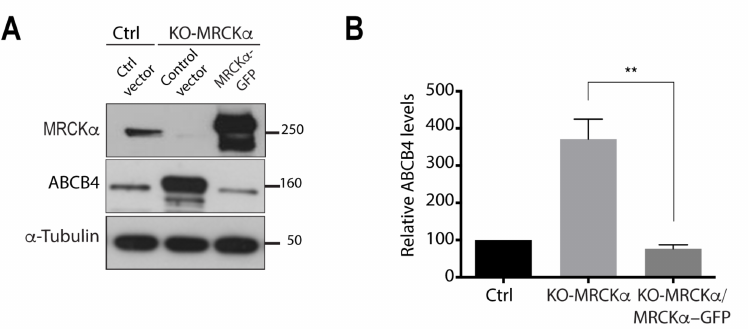
Figure 4. MRCK α knockout increases ABCB4 protein expression. ( A ) Control HEK-293 cells (Ctrl) or HEK-CRISPR for MRCK α (KO-MRCK α ) were transfected with the empty vector-pEGFP (ctrl vector) or with MRCK α -GFP. After 24 h of transfection, they were transfected with ABCB4-wt for an additional 24 h. Cells were lysed and analyzed by immunoblotting using anti-MRCK α , anti- ABCB4, and anti-a-tubulin antibodies. Presented data were cropped from the full immunoblots shown in Supplementary Figure S4. ( B ) Amounts of ABCB4 were quantified from immunoblots by densitometry. ABCB4 levels were expressed as a percentage of total expression in Ctrl cells transfected with control vector. Means ( ± SD) of at least four independent experiments are shown. ** p <